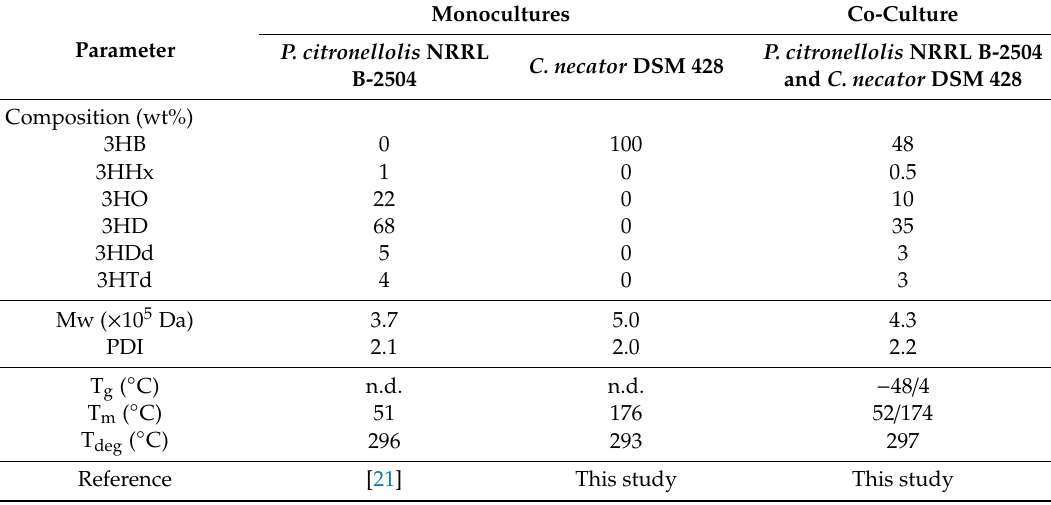
Table 2. Monomeric composition of the polymers’ samples extracted from the biomass of P. citronellolis and / or C. necator (3HB, 3-hydroxybutyrate; 3HHx, 3-hydroxyhexanoate; 3HO, 3-hydroxyoctanoate; 3HD, 3-hydroxydecanoate; 3HDd, 3-hydroxydodecanoate; 3HTd, 3-hydrotetradecanoate; M w , molecular weight; PDI, polydispersity index; T g , glass transition temperature; T m , melting temperature; T deg , degradation temperature; ∆ Hm, melting